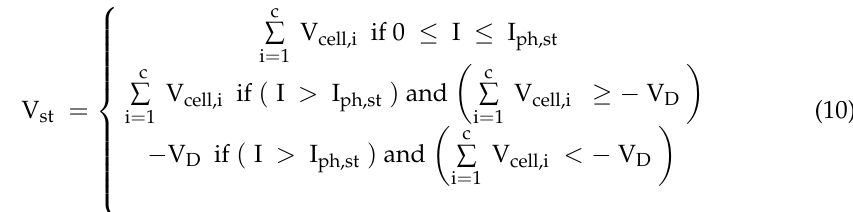
Equation (8) implies that the cell is in a normal operation if 0 ≤ I ≤ I ph,cell ,